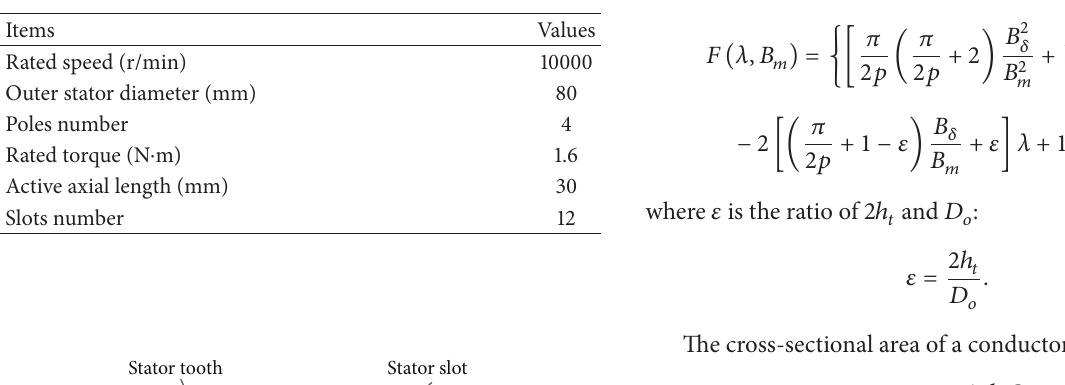
Table 1: Main parameters of the prototype motor.